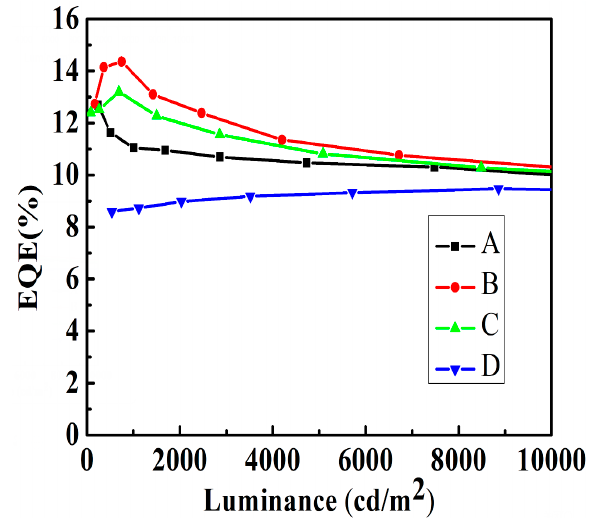
Figure 3. EQE-luminance characteristics.